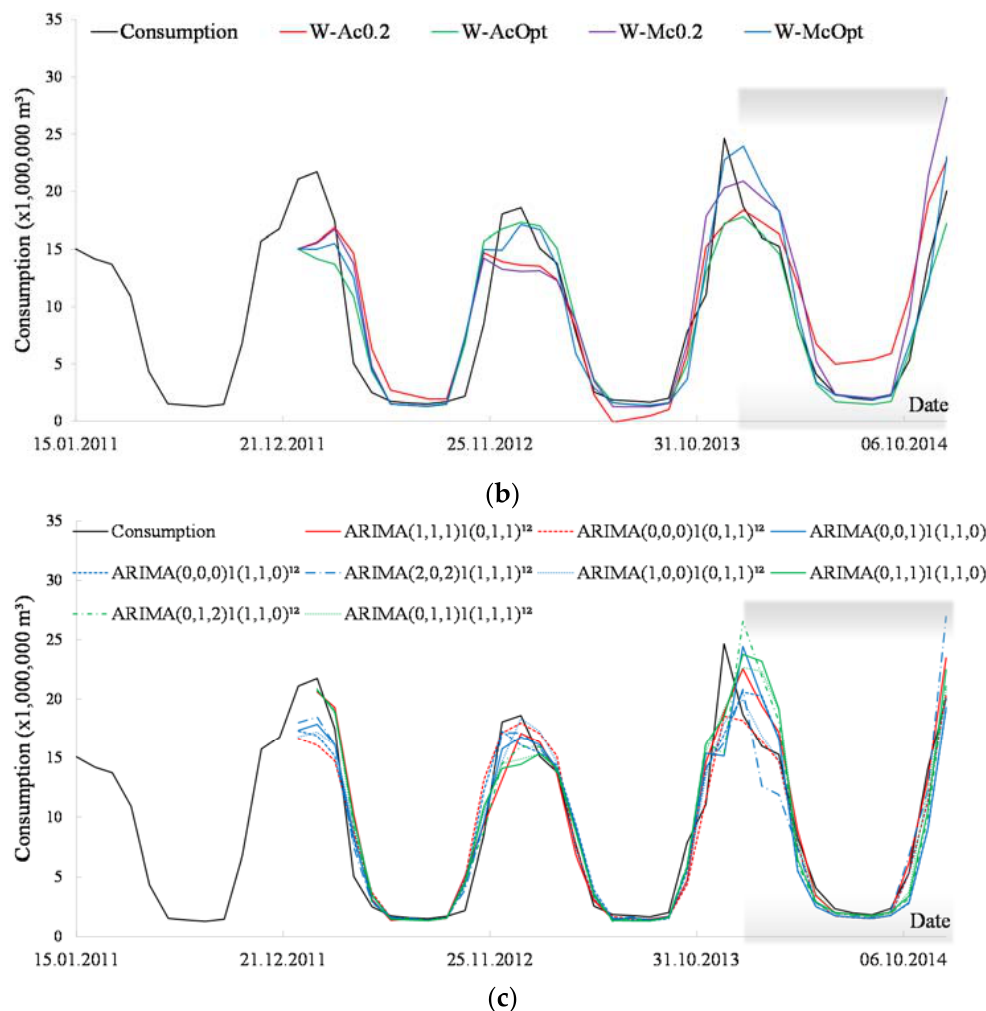
Figure 5. Forecasting results for: ( a ) Time series decomposition; ( b ) Holt-Winters exponential smoothing; ( c ) ARIMA and SARIMA model.